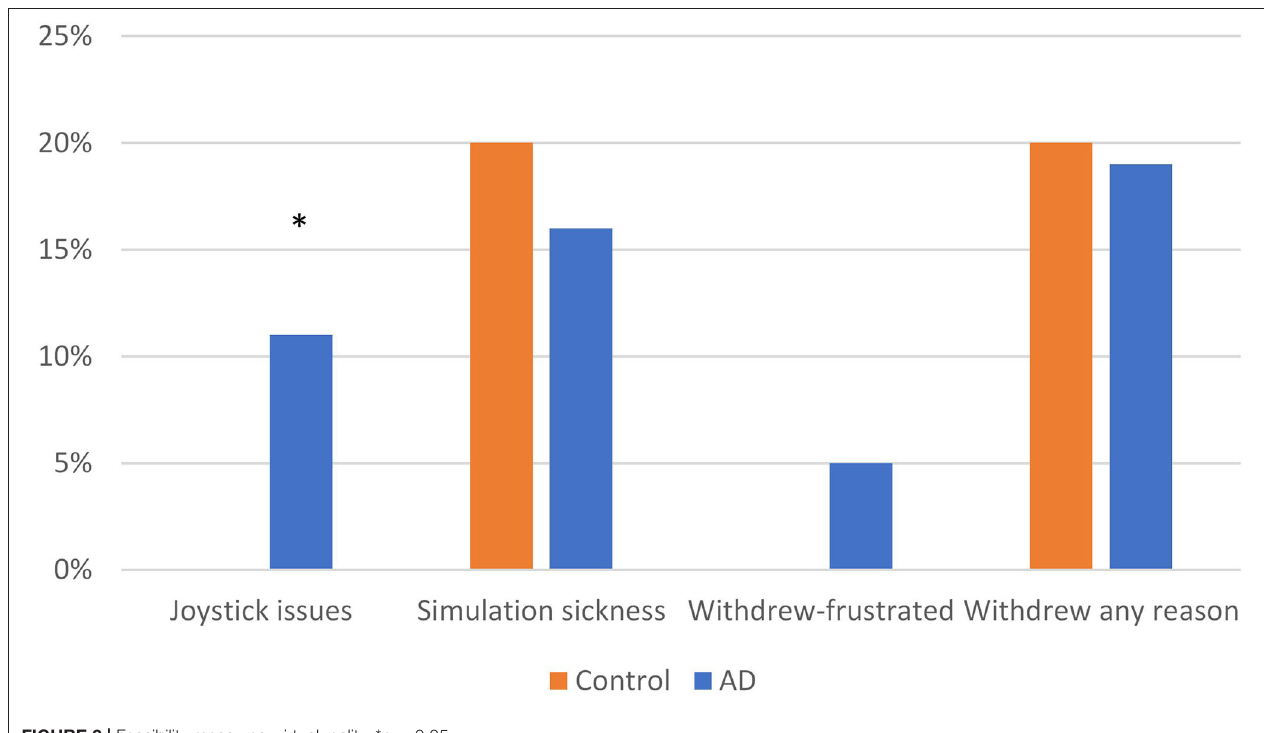
FIGURE 2 | Feasibility measures: virtual reality. * p < 0.05.